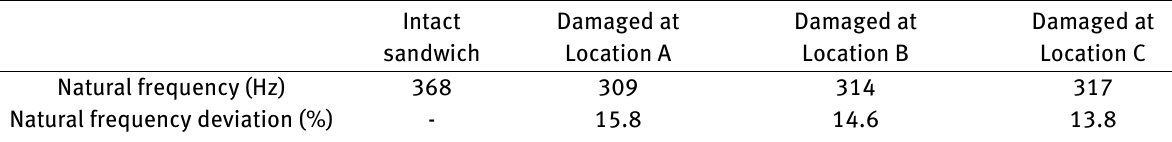
Table 5: Effect of the damage locations on the natural frequency